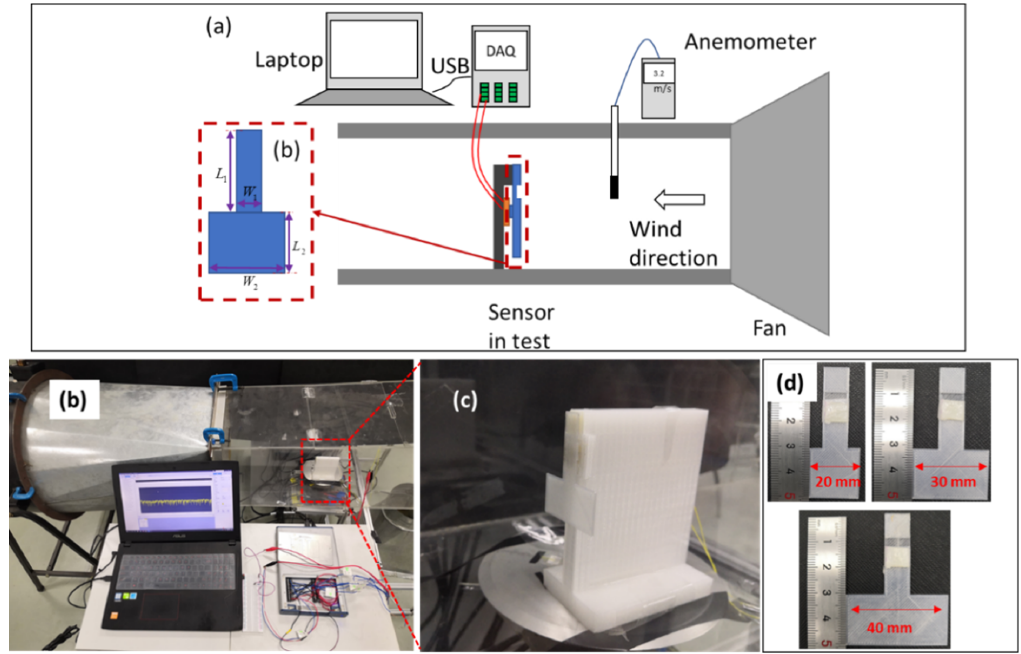
Figure 4. ( a ) Schematic of the experimental setup for airflow sensing. ( b ) Photo of the setup. ( c ) Piezoresistive airflow sensor inside a 3D-printed holder. ( d ) Different fin sizes for experimentation.